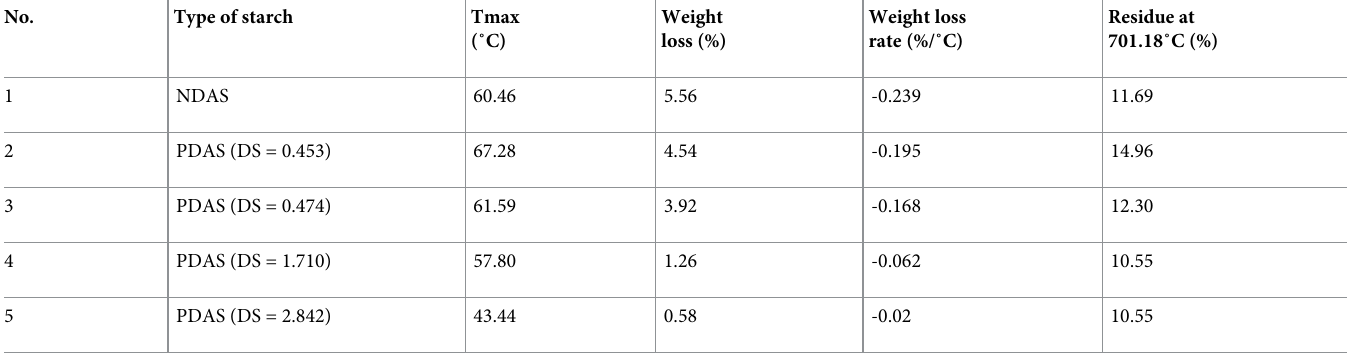
Table 3. Thermogravimetric characteristics of TGA and DTG of NDAS and PDASs with different DS (DS = 0.453, 0.474, 1.710, and 2.842). No. Type of starch Tmax Weight Weight loss Residue at (˚C) loss (%) rate (%/˚C) 701.18˚C (%) 1 NDAS 60.46 5.56 -0.239 PDAS (DS = 0.453)